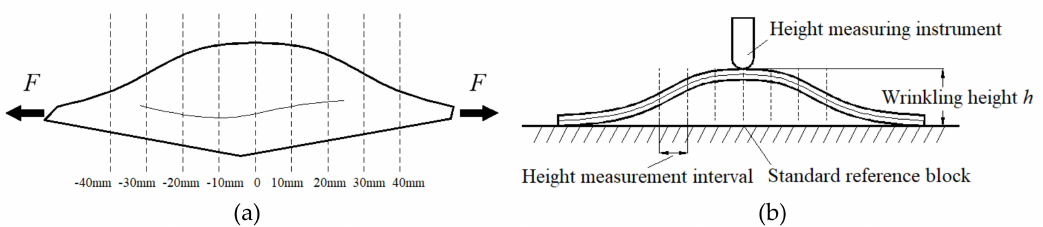
Figure 16. Wrinkling height measurement for surface detection: ( a ) Wrinkling height in the diagonal direction; ( b ) schematic of measurement